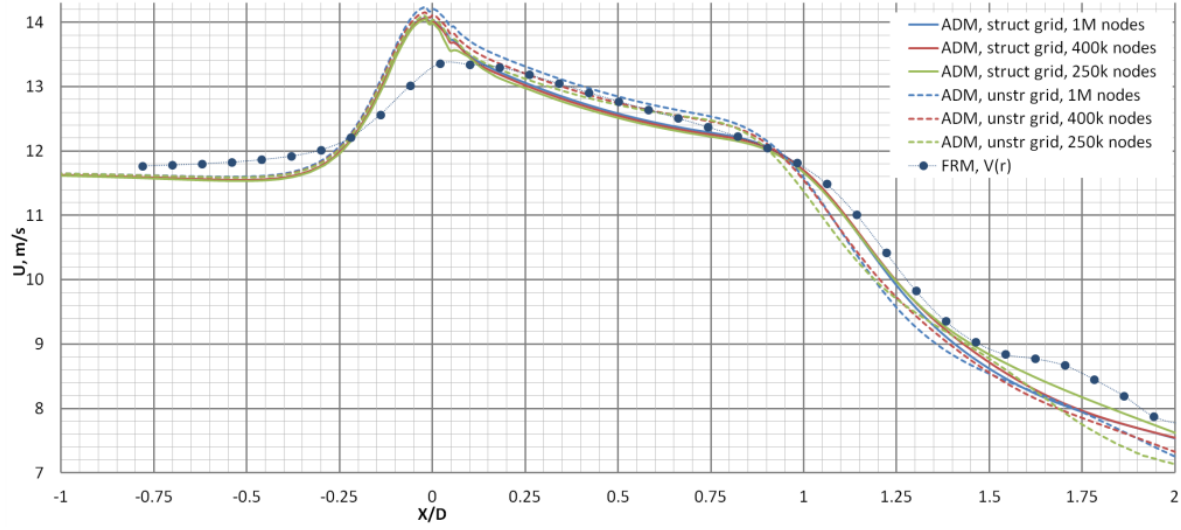
Figure 4: Streamwise velocity distribution at r / D = 0.25 , ADM (lines) and FRM (points), TSR = 4.5, x / D = 0 at the diffuser inlet.